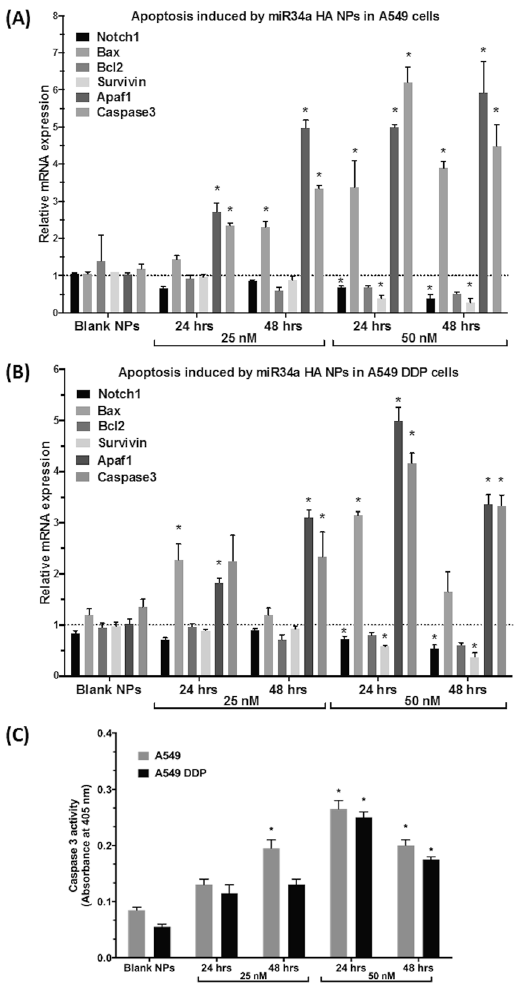
Figure 2. MicroRNA-34a induced cellular apoptosis. Dose-dependent and time-dependent analyses of genes responsible for induction of apoptotic signaling and simultaneous inhibition of anti-apoptotic genes, post transfection with HA-PEI/HA-PEG-nanoparticles encapsulated miR34a on (A) wild-type A549 and (B) cisplatin resistant A549DDP cells. Normalized to beta-actin and untreated control samples using relative quantification by delta(delta(Ct) method. (C) Caspase 3 activity levels measured using ELISA assay in both A549 and A549 DDP cells. Blank NPs–Blank HA-PEI/HA-PEG nanoparticles, miR34a HA-NPs–microRNA34a encapsulated in HA-PEI/HA-PEG nanoparticles. * Indicates comparison against control = 1. One-way ANOVA followed by Post-hoc t-test with multiple comparisons, * p < 0.05, N =